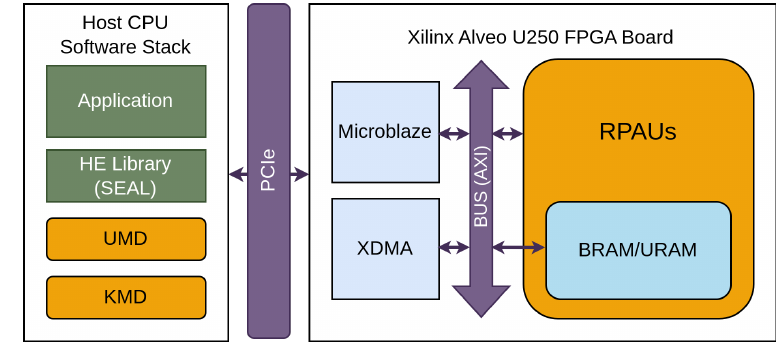
Figure 8: CPU-FPGA interface and software stack